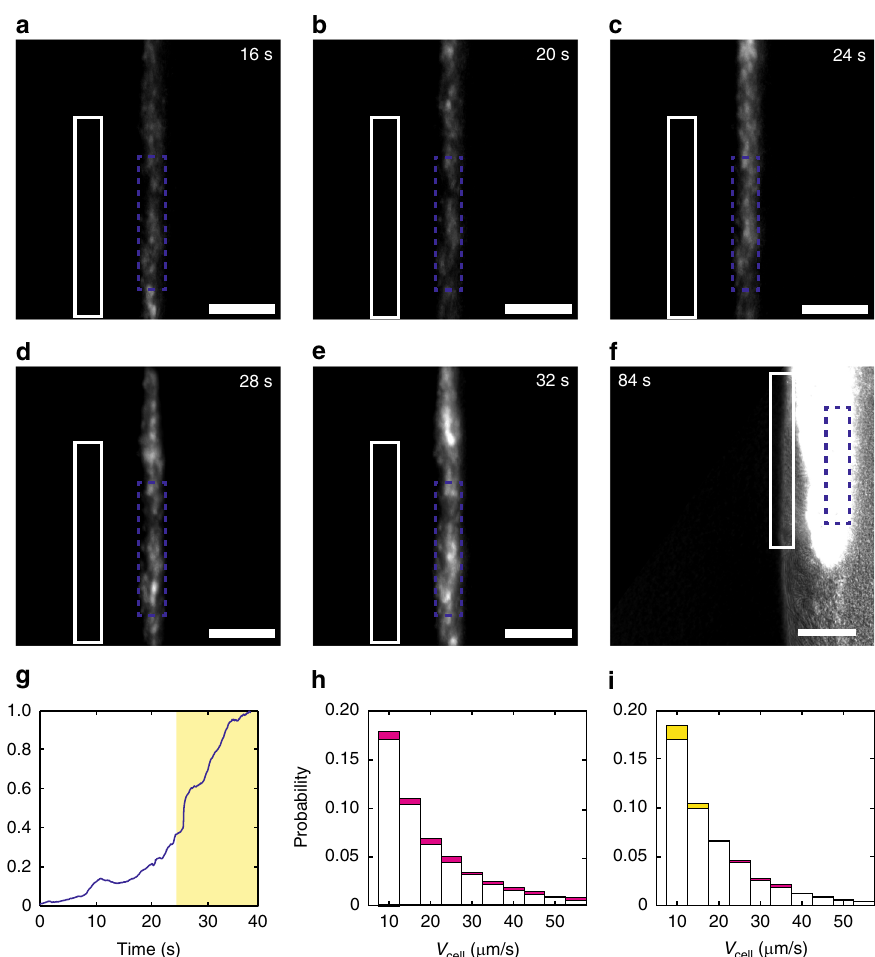
Fig. 5 Optical deactivation of fl agellar motility in the outer motile ring. A region of the outer motile ring (enclosed by solid white rectangles in panels a – f was chosen for motility deactivation with intense light ( “ Methods ” ). a – e Fluorescent image sequence of 0.1- μ m microspheres in the same fi eld of view before ( a – b ) and after ( c – e ) the deactivation of fl agella motility. Motility-deactivation light at the selected region was turned on at time = 24 s (panel c ). Scale bars, 50 μ m. f Fluorescent image of 0.1- μ m microspheres overlaid with the phase-contrast image of colony edge at time = 84 s. Microspheres were barely visible in the inner motile ring downstream of the motility-deactivation region. Scale bar, 50 μ m. g Mean fl uorescence intensity of microspheres averaged over a selected area of the inner motile ring (enclosed by blue rectangles in panels a – f ) plotted against time. The shaded area starting at time = 24 s indicates the duration of motility-deactivation. Before motility deactivation (from 0 to 24 s), the slope of fl uorescence intensity given by linear fi t is 0.013 ± 0.002 a.u. s − 1 (±sign indicates fi tting error; R 2 = 0.94); the slope increased to 0.041 ± 0.002 a.u. s − 1 ( R 2 = 0.95) after motility deactivation. h – i Speed distribution of individual cells in the inner motile ring before (panel h ) and after (panel i ) motility deactivation, respectively. The speed distribution of cells moving in CCW or CW direction were represented by columns fi lled in magenta or yellow color, respectively, and both types of columns were plotted together in the same histogram with the overlapping portion fi lled with white color. CCW bias of cellular motion changed from ~1.19 to ~1.04 in this stabilize unidirectional collective motion (in which cells align their orientations nematically but move unidirectionally) 32 , and directionally in parallel with each other as seen in our phenom-